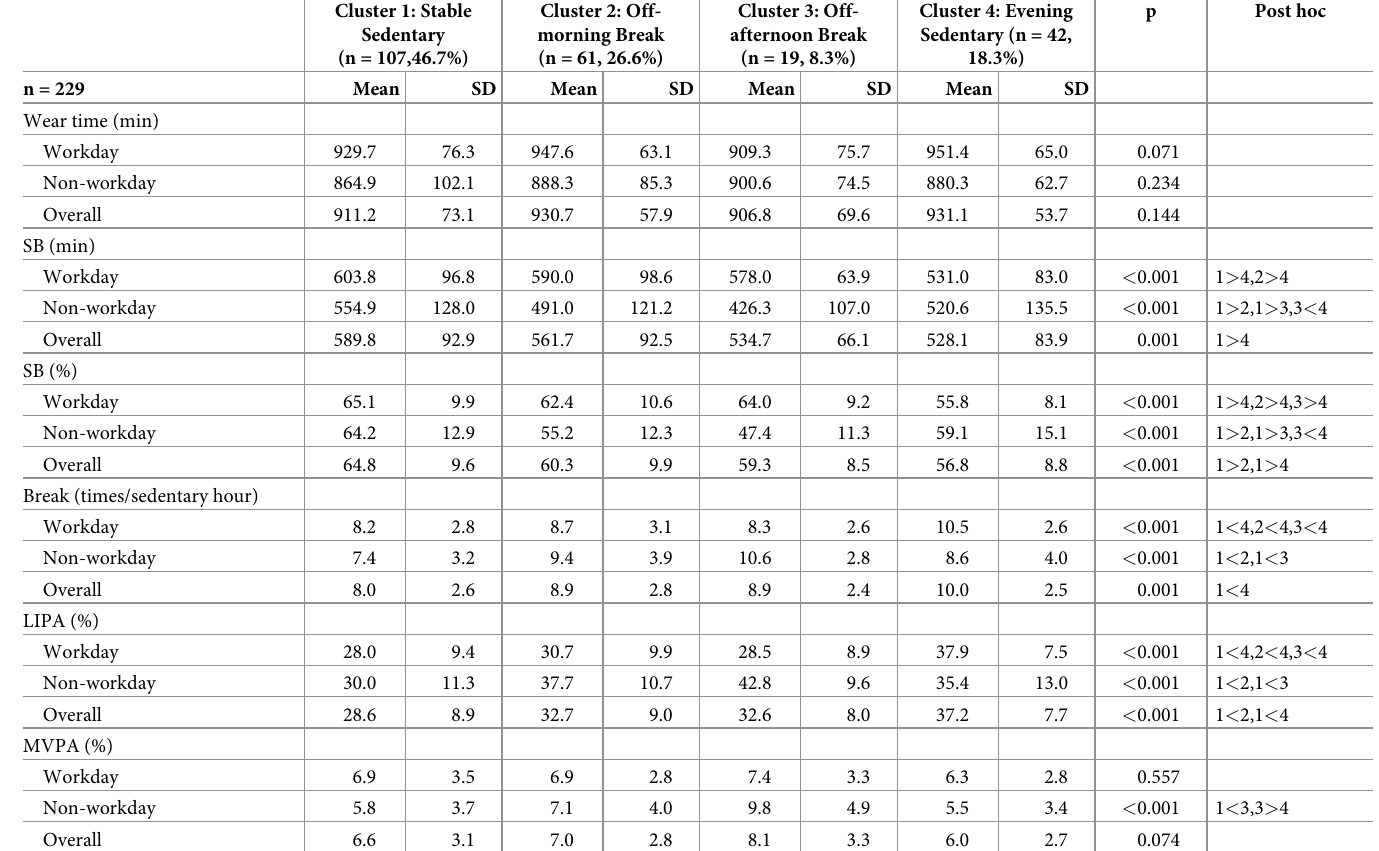
Table 2. Differences in the total amounts of objectively-measured sedentary behavior and physical activity by cluster. Cluster 1: Stable Sedentary (n =